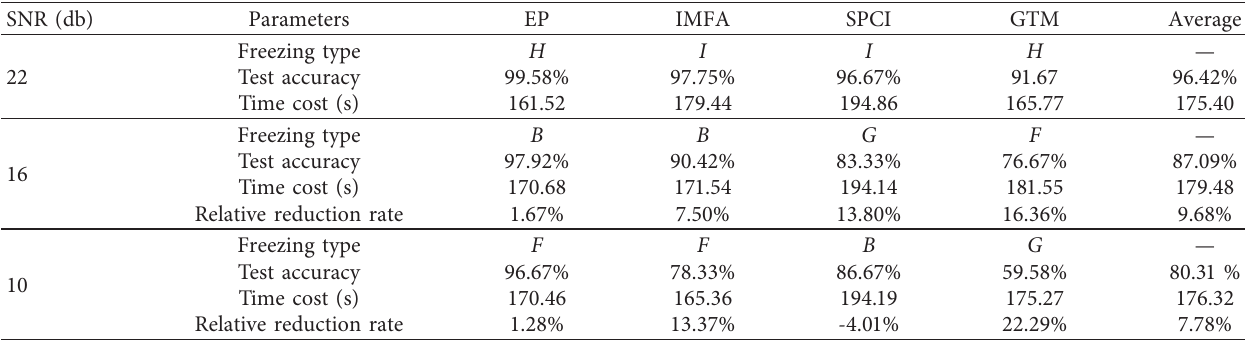
Figure 18: Performance curves of the model with type F : (a) accuracy; (b) loss. Table 11: Summary of test